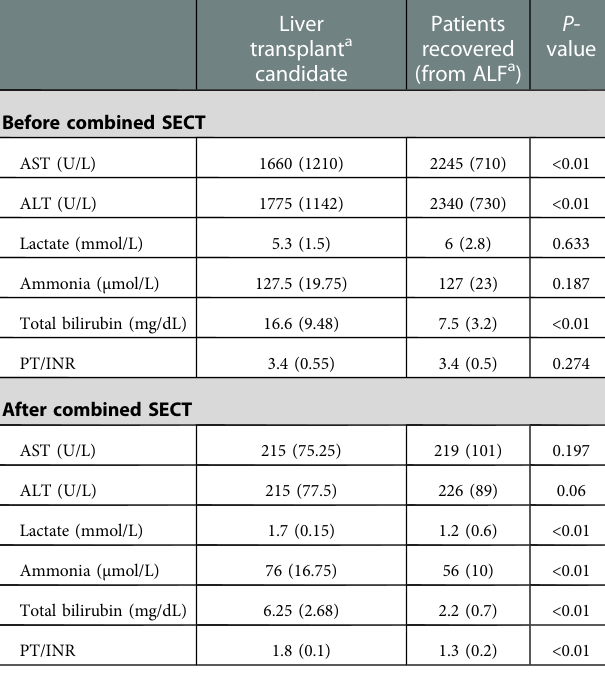
TABLE 2 Laboratory values of pediatric patients before the fi rst combined SECT and after the last combined SECT.